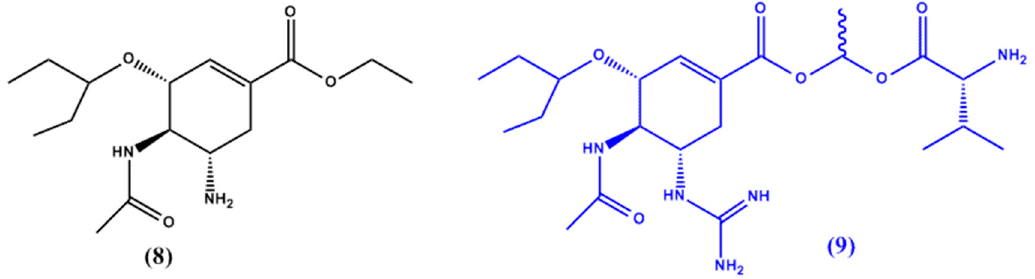
Figure 4. Chemical structures of oseltamivir ( 8 ) and its GOC-L-Val prodrug 9 .